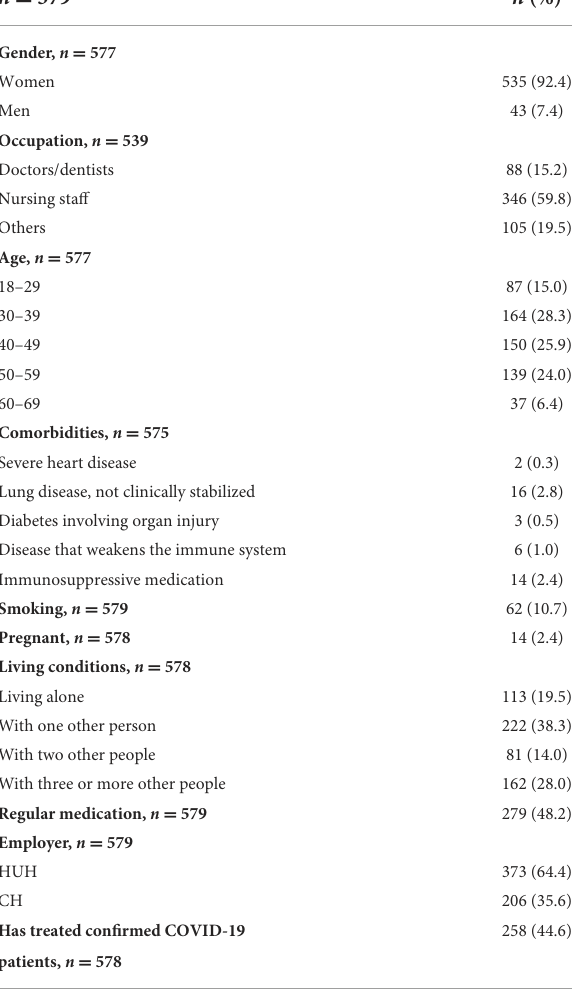
TABLE 2 Characteristics of the